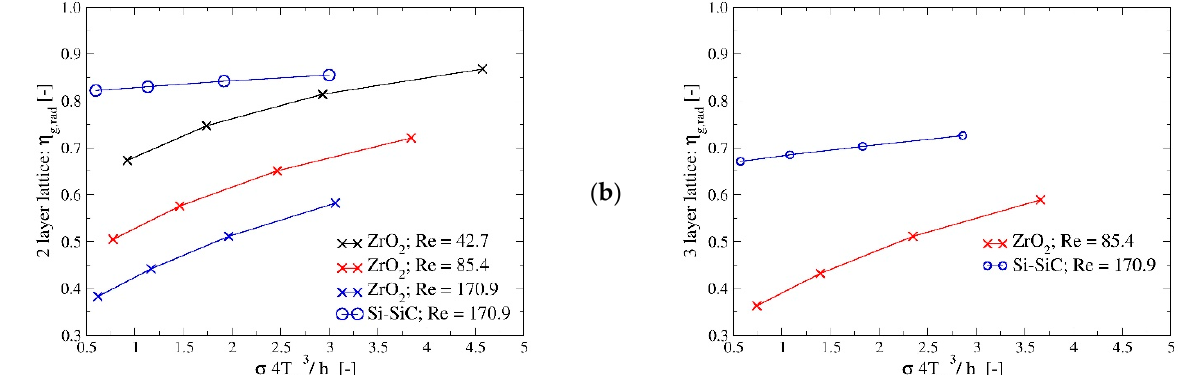
Figure 10. ( a , b ) Effect of radiative heat transfer on the fin global efficiency for the 2 and 3 layers lattice configurations. The picture compares the global efficiency with the non-dimensional group defined in Equation (6).